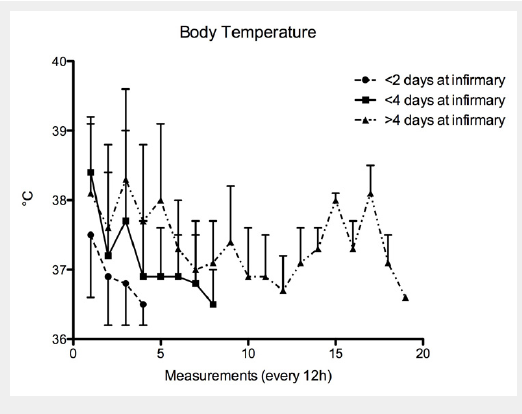
Body temperature of patients according to their length of stay at infirmary.